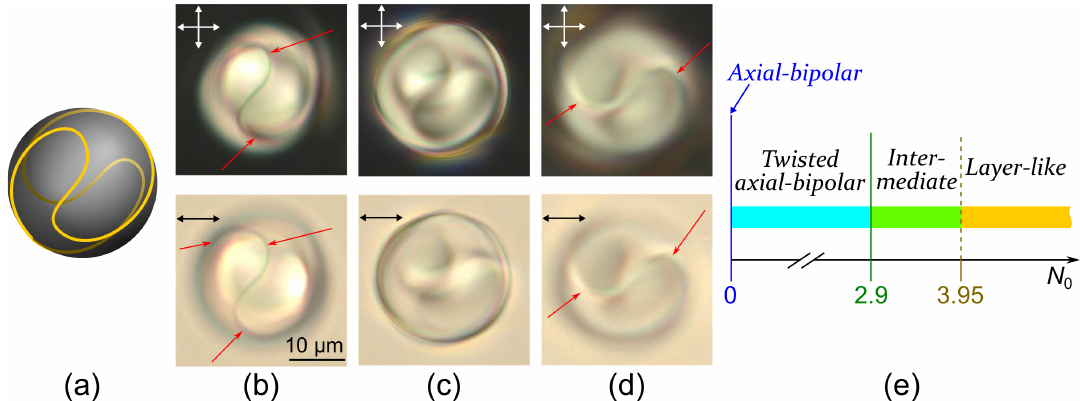
Figure 5. Scheme of the twisted defect loop on the droplet surface ( a ). POM photos of cholesteric droplets at N 0 = 5.2 taken in the crossed polarisers (top row) and without analyser (bottom row). The microscope is focused on the linear defect above the droplet centre ( b ), on the droplet centre ( c ) and on the linear defect below the droplet centre ( d ). ( e ) Diagram of the droplet state observed experimentally at various droplet sizes expressed by the relative helicity parameter N 0 . Single arrows indicate the position of the linear